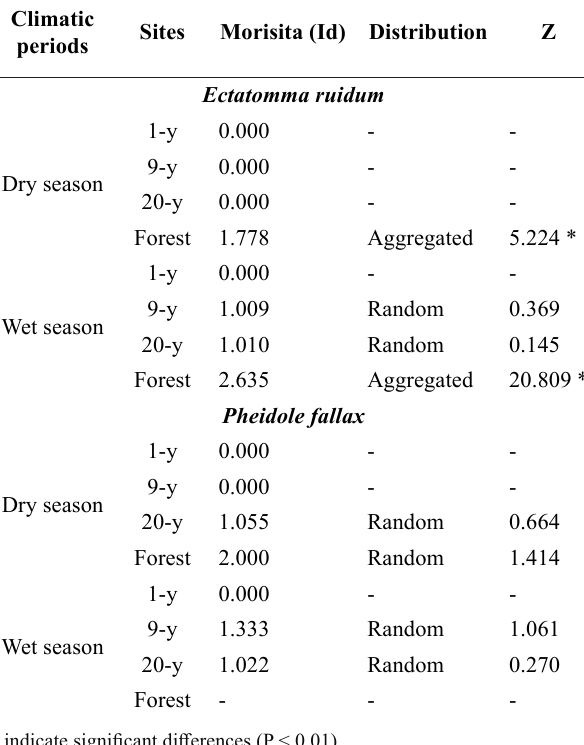
Table 1. Spatial distribution of nest for E. ruidum (E) and P. fallax, (P) at local scale. n: number of nest, R: Clark & Evans nearest- neighbour index, Z: Test of